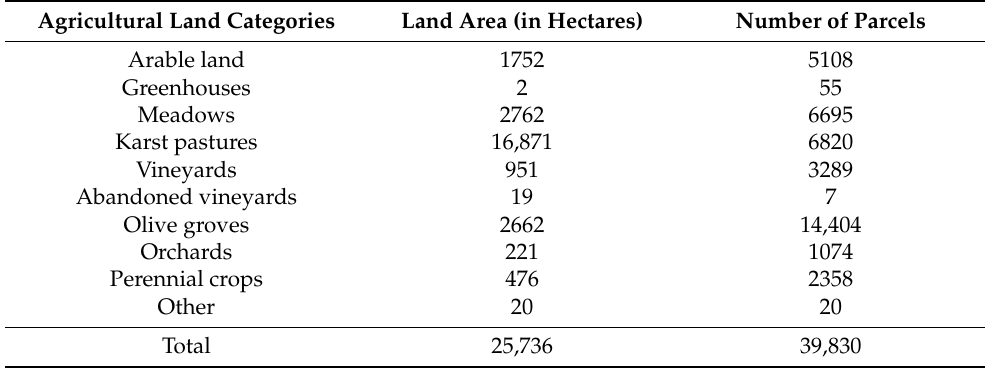
Figure 2. Agricultural land use pattern. Enlarged area presents agricultural parcels’ spatial pattern in Petrovo polje . Table 3. Utilized agricultural area by categories (ha) and number of parcels within the land use category (Šibenik region, Croatia).